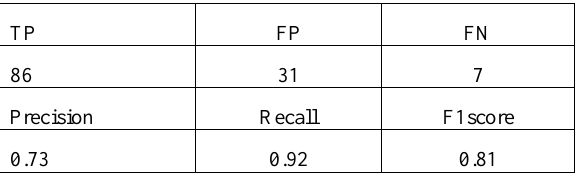
Table 4 . Quantitative evaluation